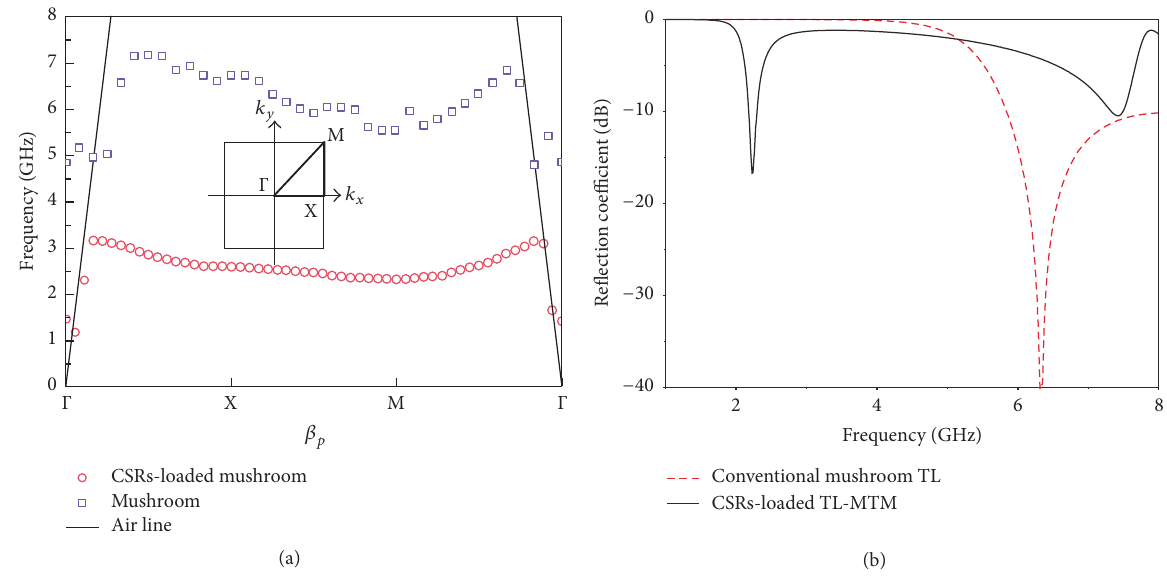
Figure 2: Dispersion diagram and simulated 𝑆 -parameters of the conventional mushroom and CSRs-loaded mushroom TL structures.